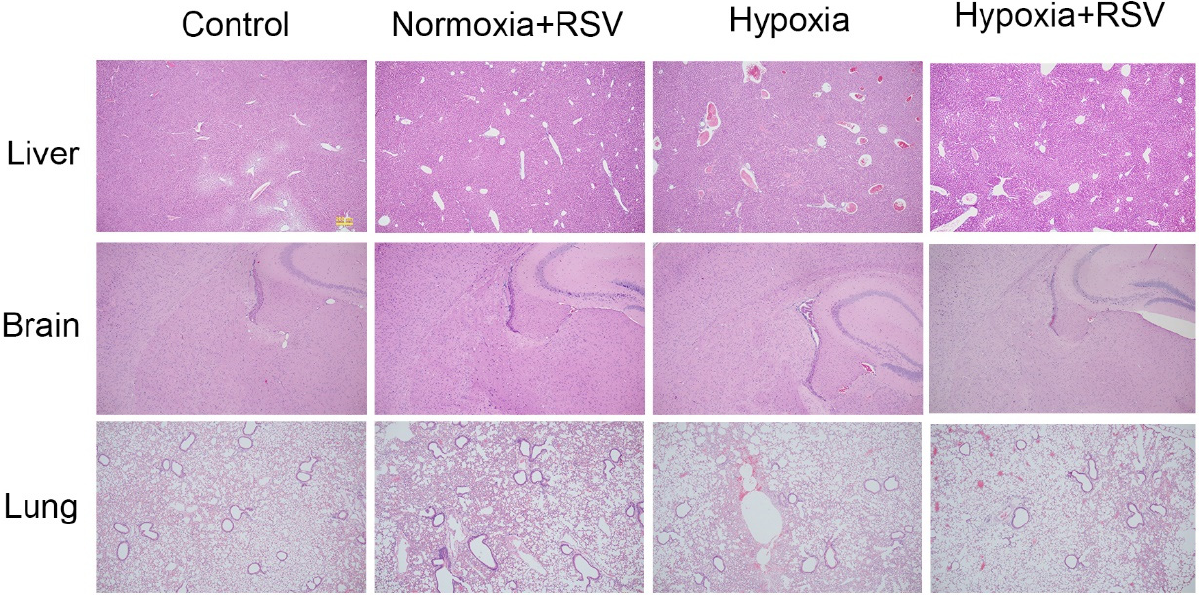
Figure 6. H&E analysis of liver, brain, and lung tissues of mice in the normal, normal with RSV, hypoxia, and hypoxia with RSV groups.